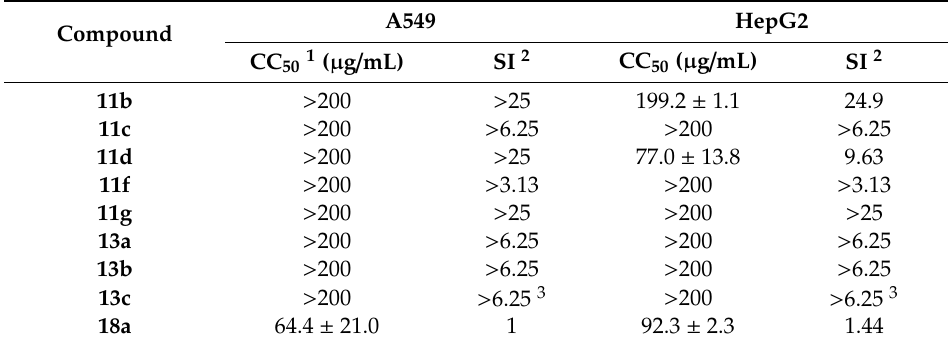
Table 3. Cytotoxicity data of selected compounds on A549 and HepG2 Table 3. C ytotoxicity data of selected compounds on A549 and HepG2 cells.